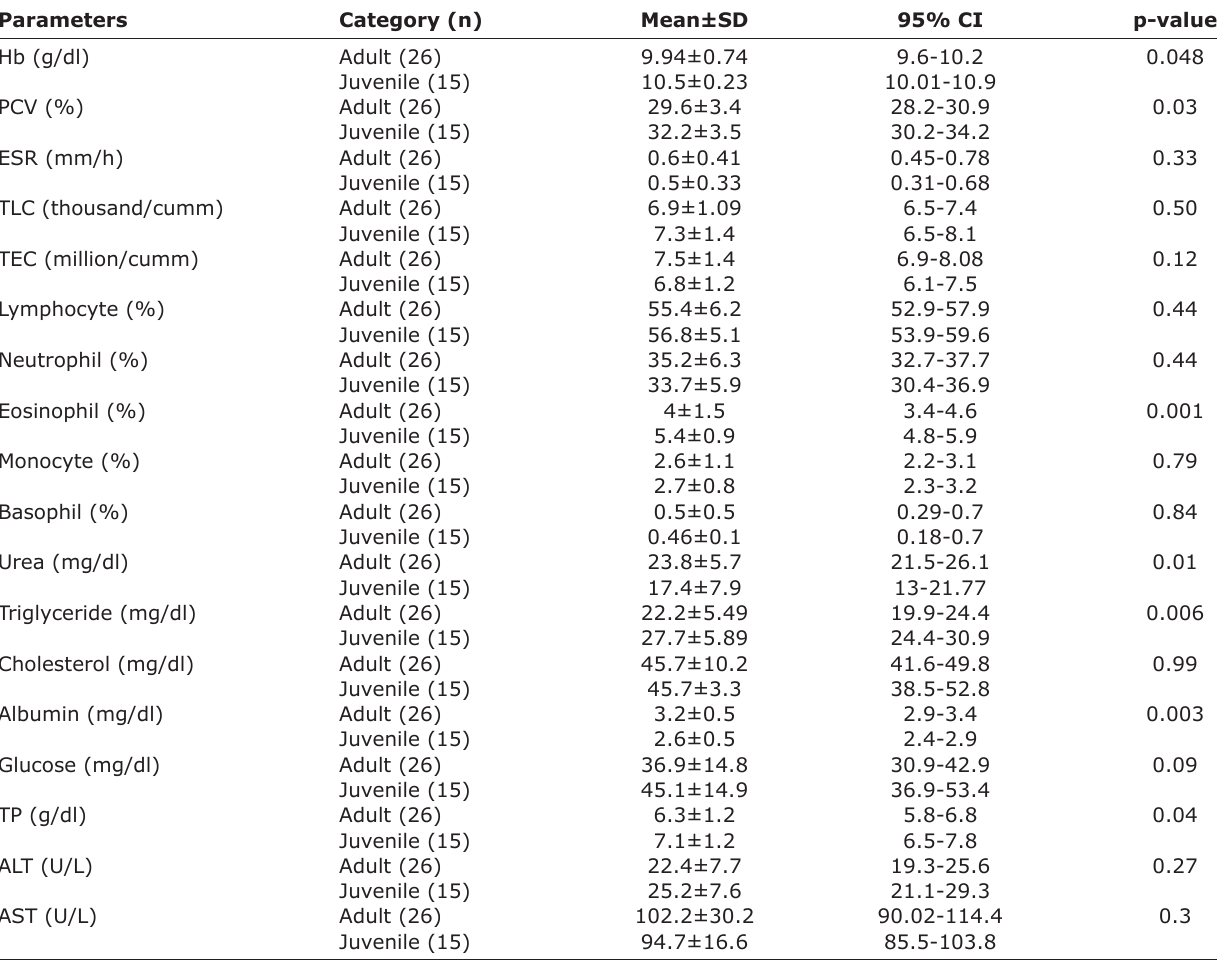
Table-2: Comparison of biochemistry and hematology between healthy adult and juvenile indigenous sheep (O. aries) of Bangladesh.